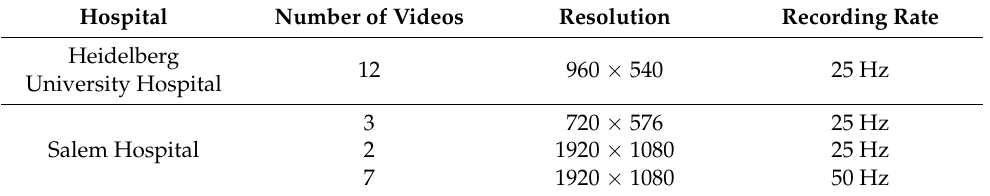
Table 2. Resolution and recording rate for the released training set of Endovis challenge